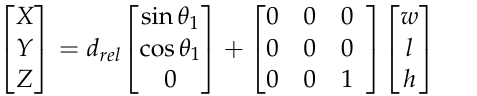
where X , Y , and Z are the space coordinate values of objects; d rel is the distance between VUT and objects; θ 1 is the angle between VUT and objects (bearing); w , l , and h are the width, length, and height of the detected objects,